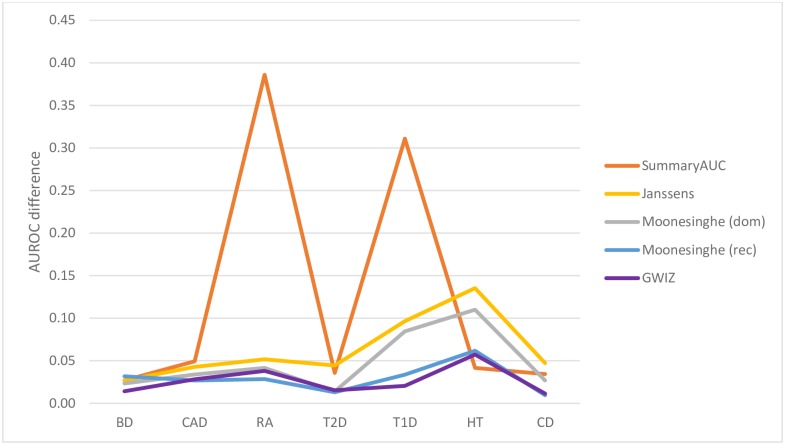
Comparison of AUROC predictions accuracies made by G-WIZ and SummaryAUC where the difference between the actual AUROC and predicted AUROC for 7 different disorders is shown.Bipolar disorder (BD), coronary artery disease (CAD), Crohn’s disease (CD), hypertension (HT), rheumatoid arthritis (RA), type 1 diabetes (T1D), and type 2 diabetes (T2D).